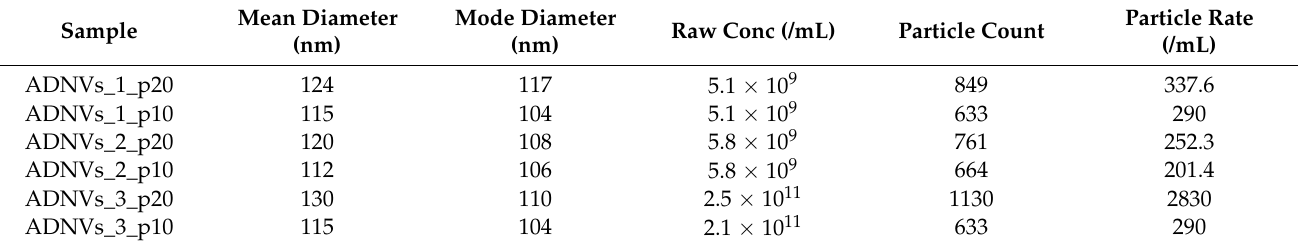
Table 2. TRPS analysis data.